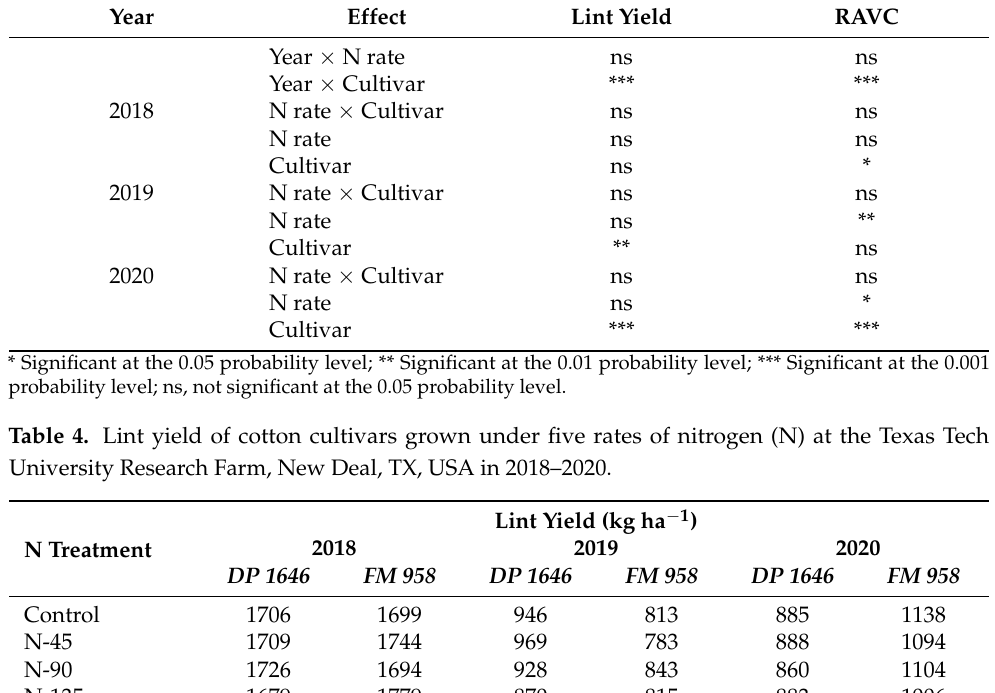
Table 3. Statistical significance of differences in lint yield and revenue above variable cost (RAVC) due to treatments, among cultivars and N rates, and interactions by year.